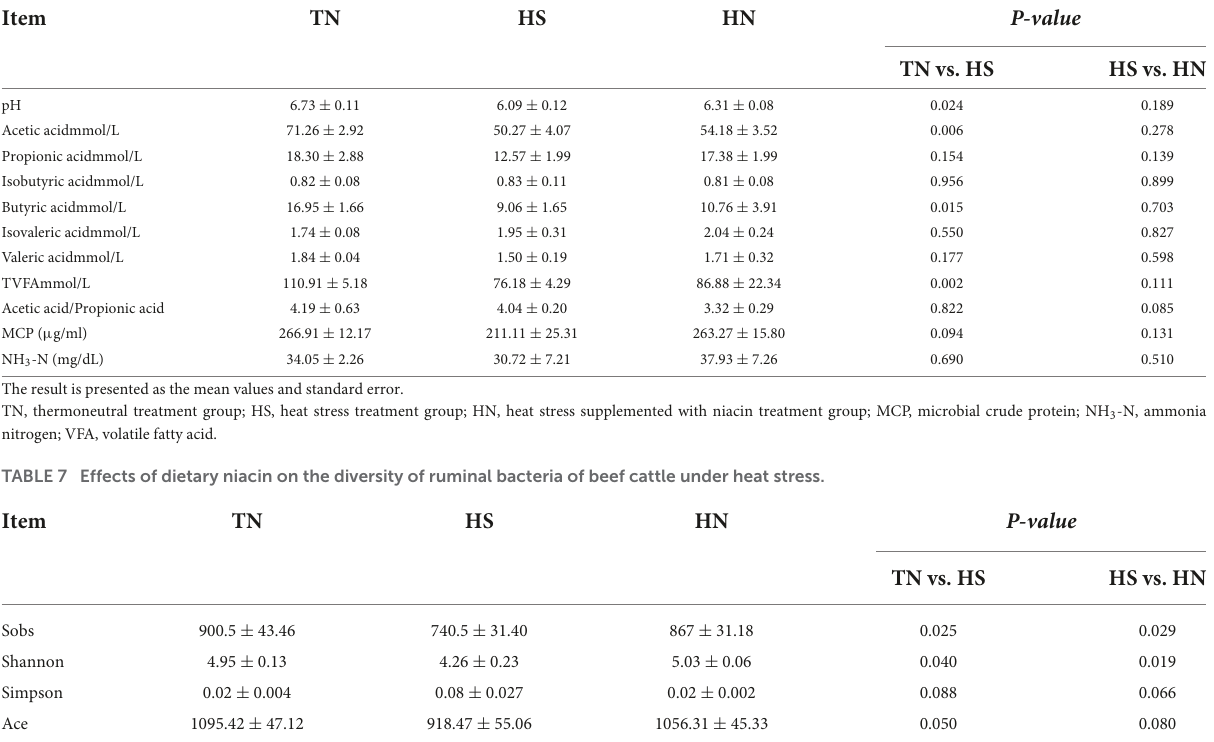
TABLE 6 Effects of dietary niacin on rumen fermentation parameters of beef cattle under heat stress.